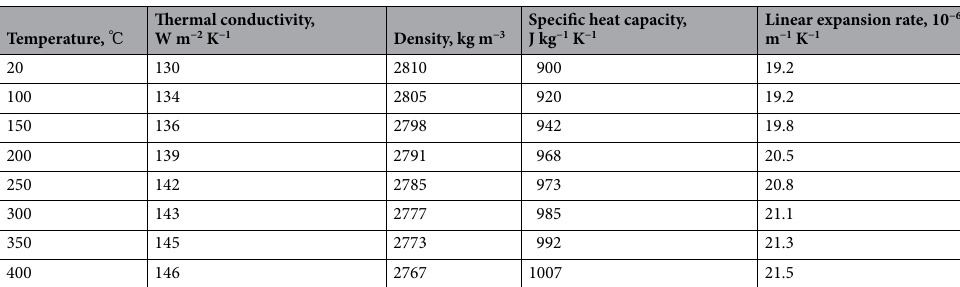
Table 4. Thermophysical parameters of the piston body material at different temperatures.